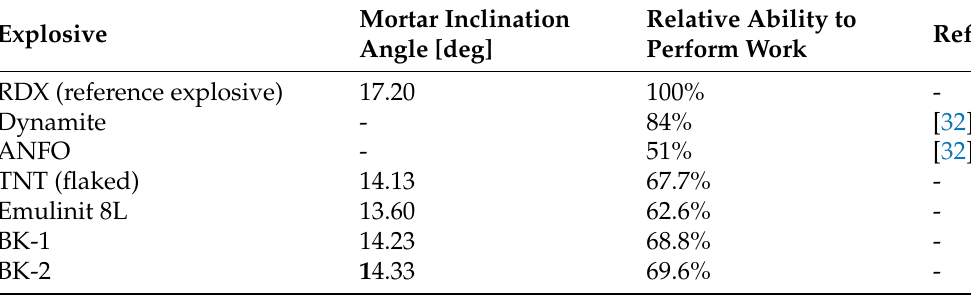
Table 3. Summary of the ability of the tested explosive charges to perform mechanical